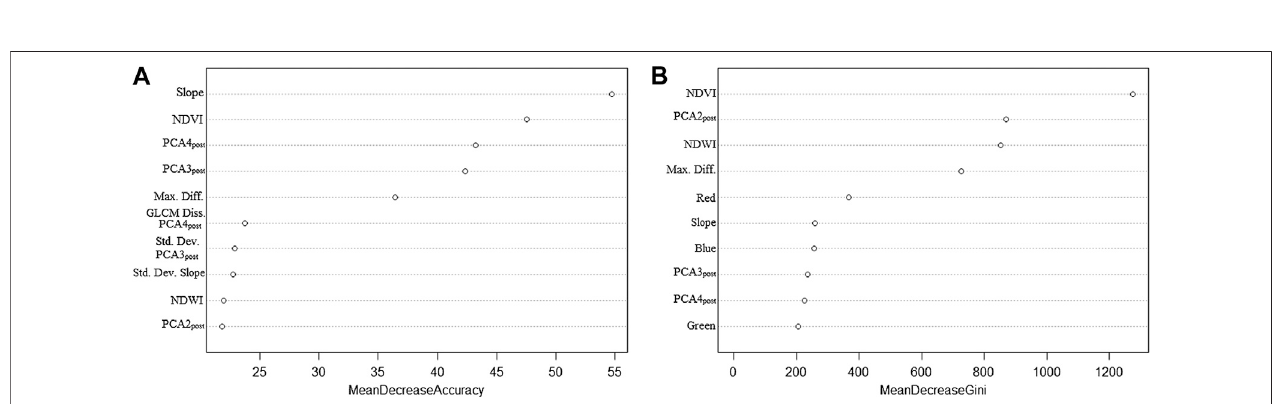
FIGURE 4 | The ten most important features for the classi fi er developed with post-event dataset in model area 5: (A) shows how selected features affect model accuracy when removed from the dataset, (B) indicates how selected features affect model purity when removed from the dataset.